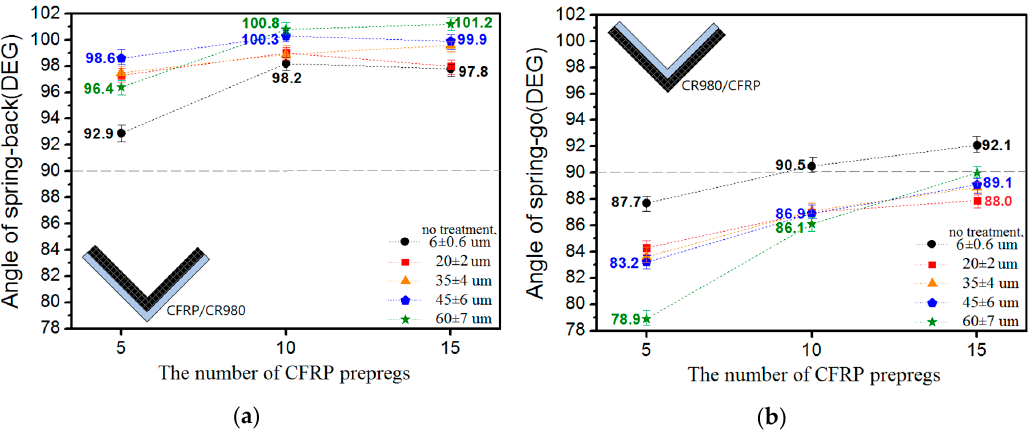
Figure 4. Angles of hybrid composites through V-bending test according to the roughness at bonding area and the laminating number of CFRP prepregs: ( a ) Spring-back angles of the CFRP/CR980; ( b ) Spring-go angles of the CR980/CFRP.